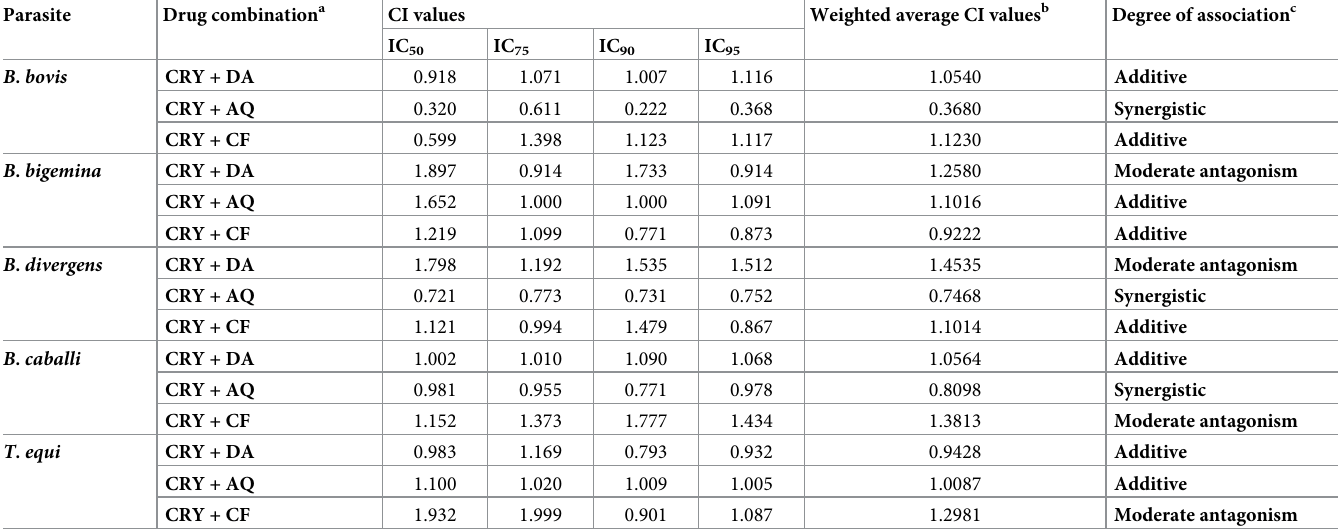
Table 2. The effect of CRY with DA, AQ, and CF against Babesia and Theileria parasites in vitro . Parasite